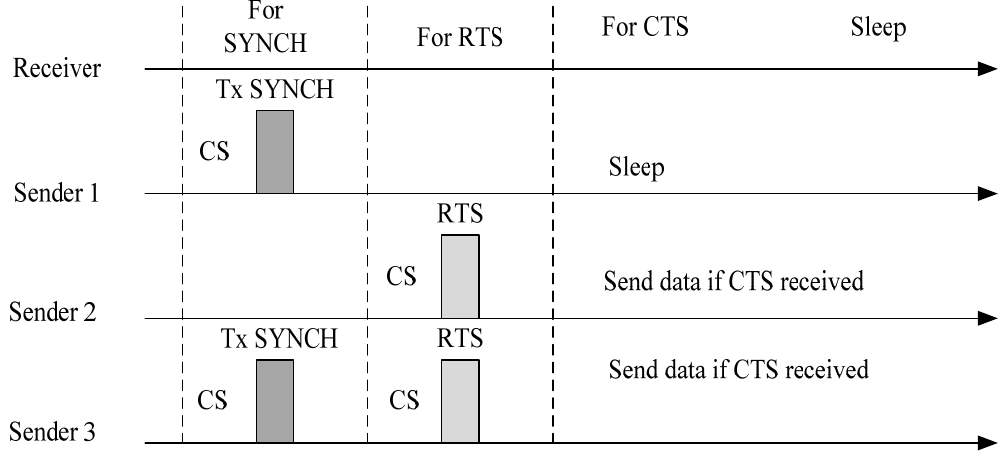
Figure 6. Timing relationship between a receiver and different senders. CS is carrier